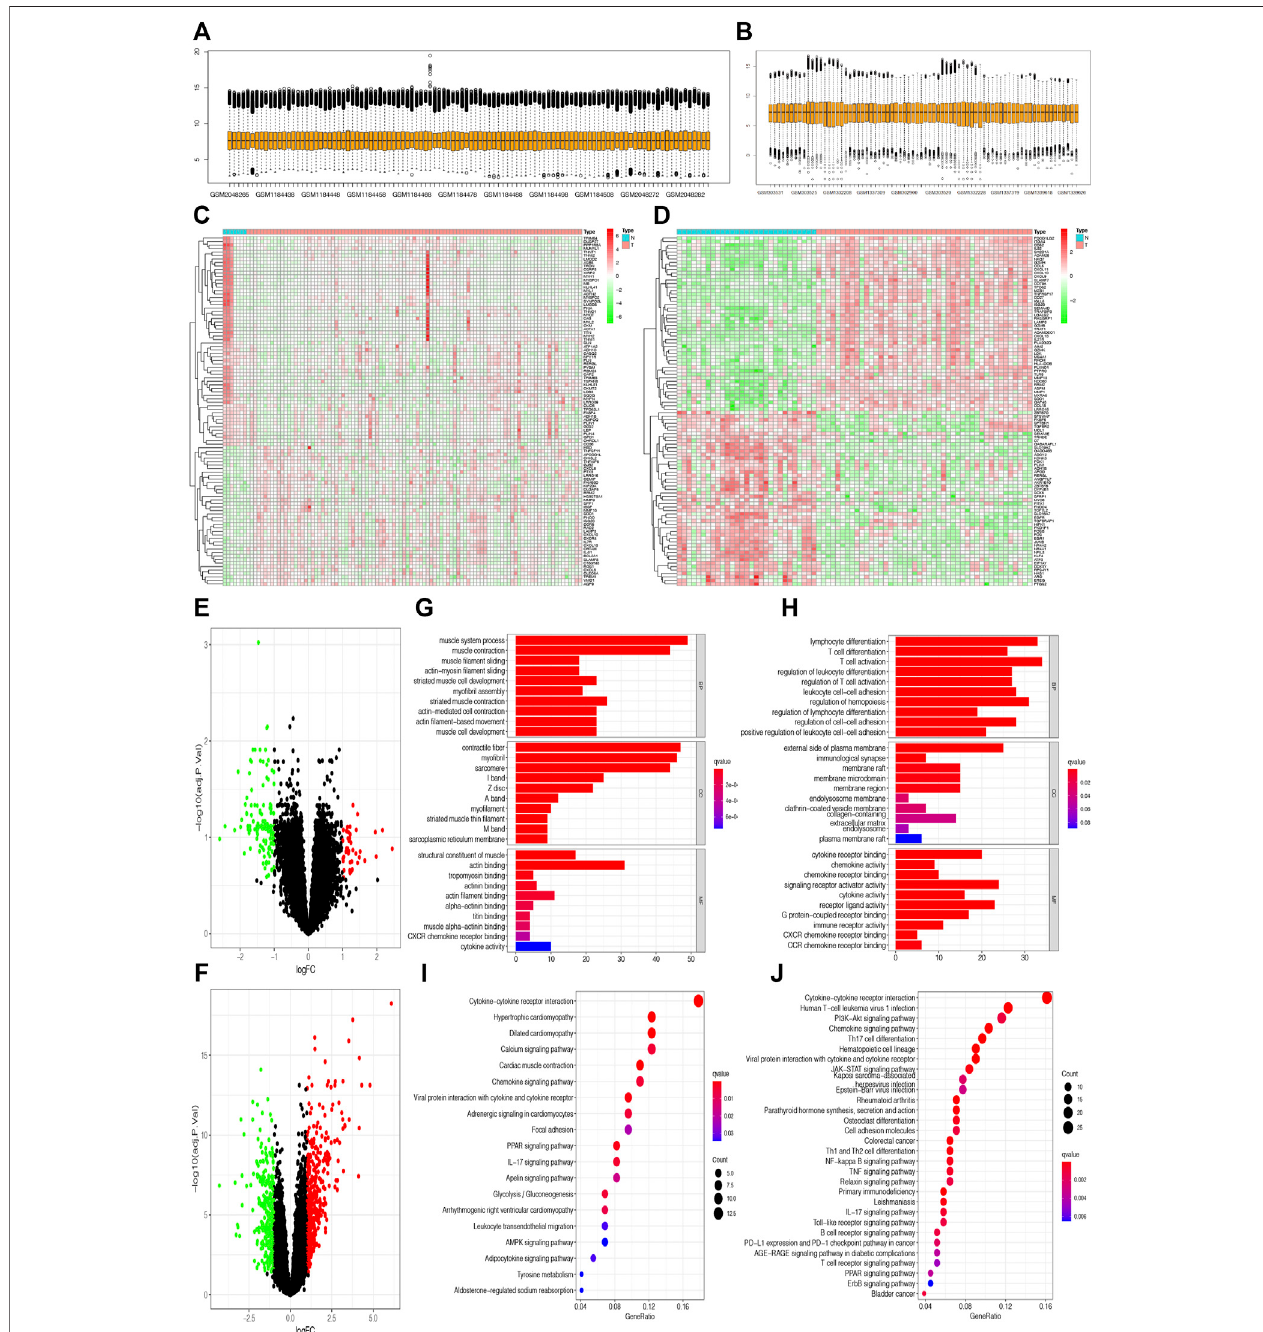
FIGURE 2| Selection ofdifferentially expressed genes and enrichment ofrelated pathways. (A and B) Geneexpression in different sampleswas normalized in the GPL570and GPL96 databases. (C and D) The heatmaps show thetop 50differentiallyexpressed genesbetween synovial tissues and rheumatoid arthritis (RA)tissues intheGPL570andGPL96databases. (EandF) Thevolcanoplotsshowthedifferentiallyexpressedgeneswithfalsediscoveryrate(FDR) < 0.05and|logFold-Change| ≥ 1 in the GPL570 and GPL96 databases. (G and H) The Gene Ontology (GO) enrichment analysis based on differentially expressed genes was performed in the GPL570 and GPL96 databases. (I and J) The Kyoto Encyclopedia of Genes and Genomes (KEGG) enrichment analysis was performed to explore the associated pathways in the GPL570 and GPL96 databases.